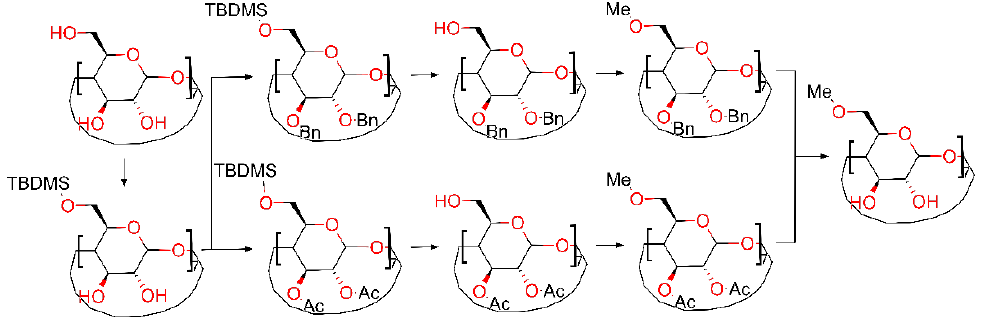
Figure 1. Classic organic chemistry protocol compiled from ref [8–10].